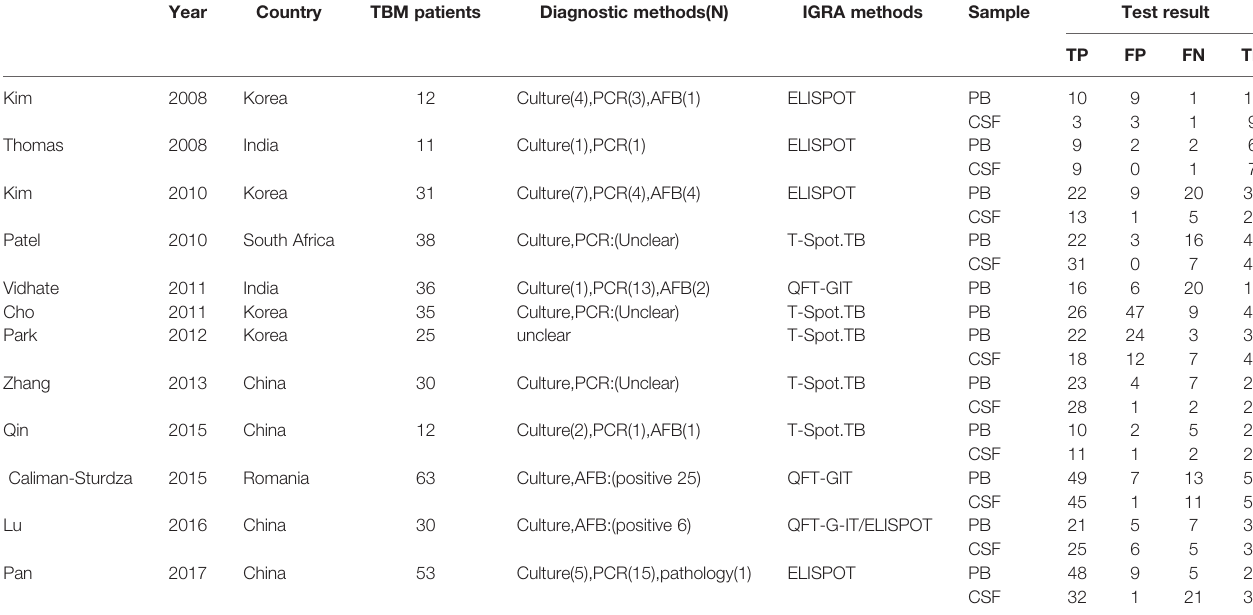
TABLE 2 | Principal data characteristics of included